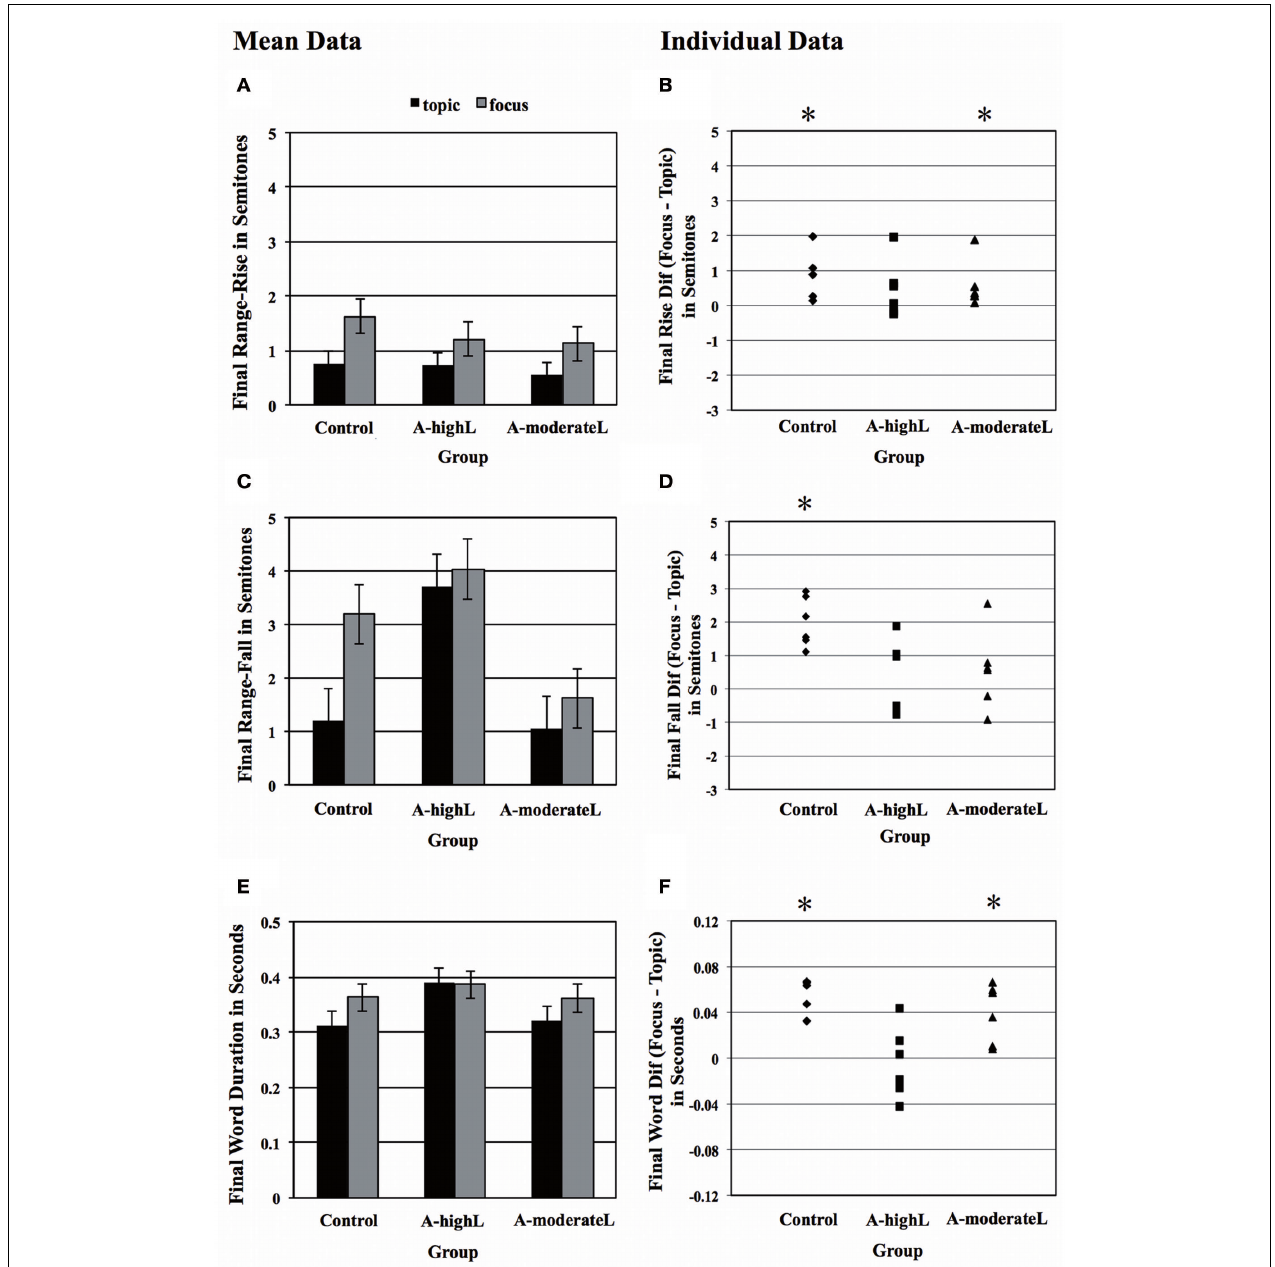
range-fall and SE by group. (D) Individual data for range-fall difference (focus–topic) by group. (E) Mean word duration and SE by group. (F) Individual data for duration difference (focus–topic) by group. * p <